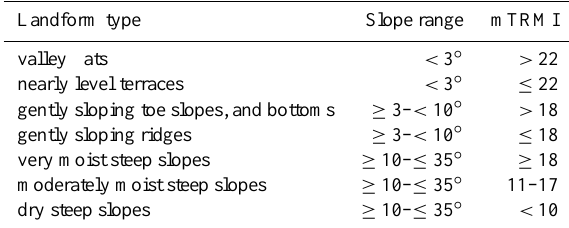
Table 3. Landform types with corresponding slope and